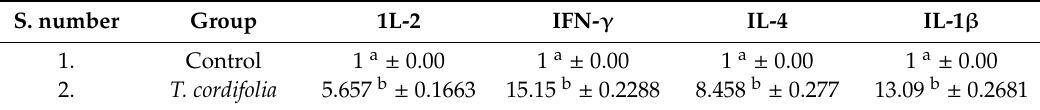
Table 2. Quantitative real time PCR analysis of immune response genes (expressed as fold change in the immune response gene transcripts) in chicken PBMCs after T. cordifolia treatment at 10 mL / bird / day from day old to 4 week of